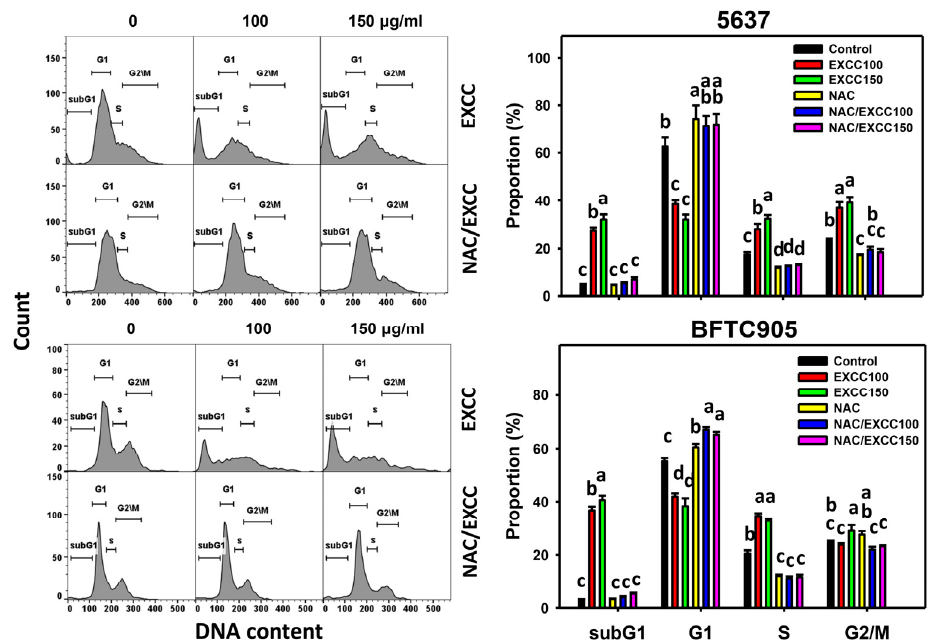
Figure 2. Cell cycle change by EXCC and NAC/EXCC. Two bladder cancer cell lines (5637 and BFTC905) were tested. Cells were treated with control (0.1% DMSO) and EXCC (100 and 150 μ g/mL) for 48 h. NAC/EXCC is the NAC pretreatment (10 mM, 1 h) coupled with EXCC posttreatment (100 and 150 μ g/mL, 48 h). Statistically different lower-case letters were given to each treatment. Non-overlapping letters between different treatments indicate significant results ( p < 0.05). Data, means ± SD ( n = 3). For the example of subG1 (5637 cells), the EXCC 0 (control), 100, and 150 indicating “c, b and a” show significant results between each other because these letters were non-overlapping. In contrast, NAC, NAC/EXCC 100, and NAC/EXCC 150 indicating “c” show nonsignificant results be- cause these letters overlap.